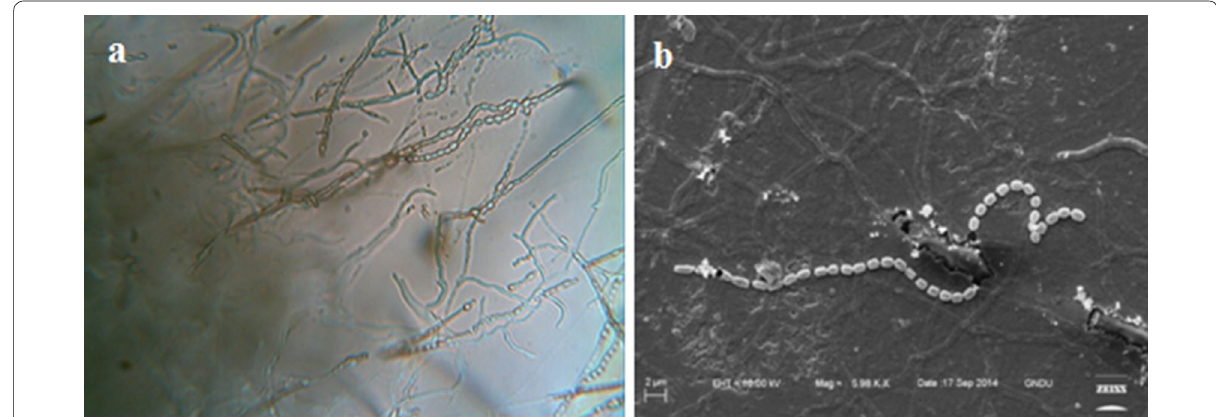
Fig. 1 a Light micrograph at 100X showing rectus-flexibilis spore chains on aerial mycelium of Streptomyces sp. MR14 grown on Starch Casein Nitrate Agar for 5 days at 28 °C. b Electron microscopic view of aerial mycelium showing smooth surface of spores of Streptomyces sp. MR14 at